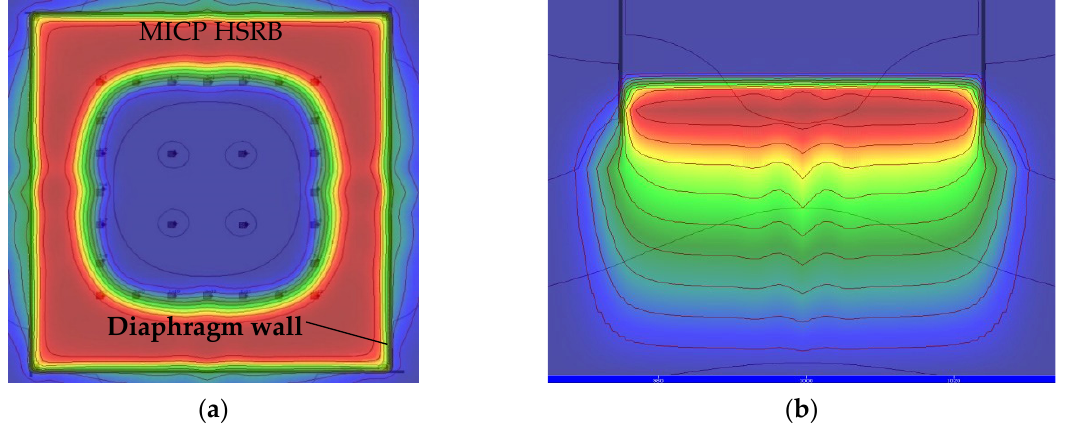
Figure 21. Migration of S. pasteurii in condition 8: ( a ) Horizontal; ( b ) Vertical.